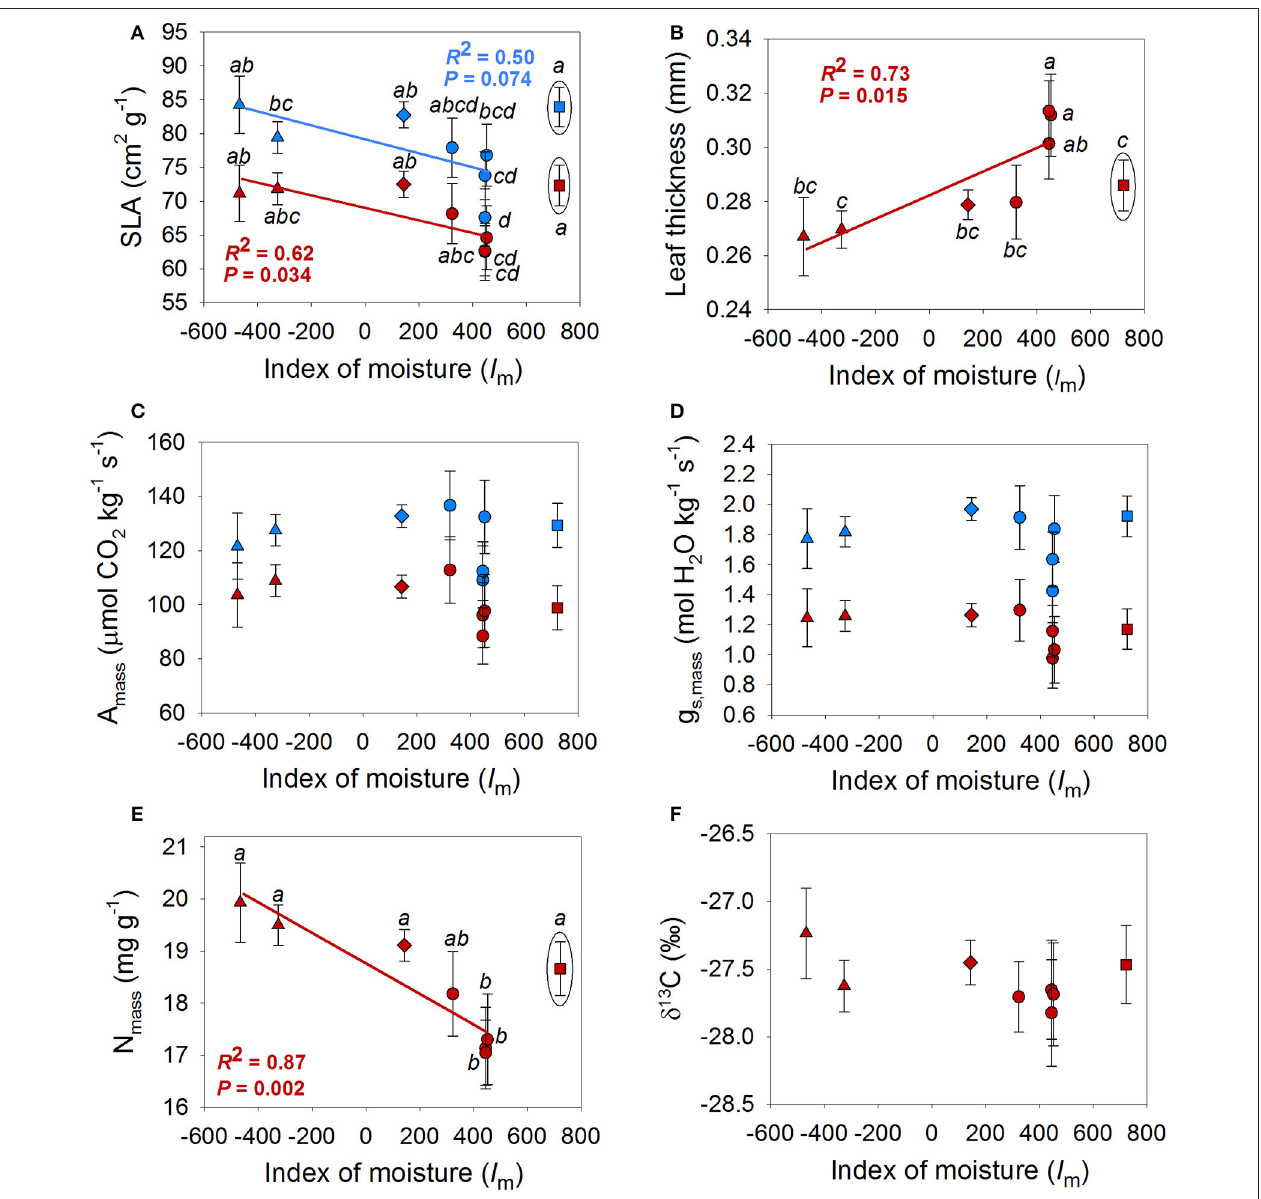
FIGURE 4 | Population means for specific leaf area (SLA) (A), leaf thickness (B) , mass-based photosynthetic rate (A mass ) (C) , mass-based stomatal conductance (g s, mass ) (D) , mass-based leaf nitrogen content (N mass ) (E) and 13-Carbon isotope composition ( δ 13 C) (F) in the wet season (blue) and dry season (red) in relation to the index of moisture of the population ( I m ). Populations that belong to the same climatic region are represented by the same symbols are; Honduras, triangles; Dry Costa Rica, diamonds; Belize, circles; Mesic Costa Rica, squares. Linear fits ( R 2 ) and significant levels ( P ) were obtained when the “Mesic Costa Rica” population was excluded from the analyses (see further explanation in the text). Only significant or marginally significant relationships are